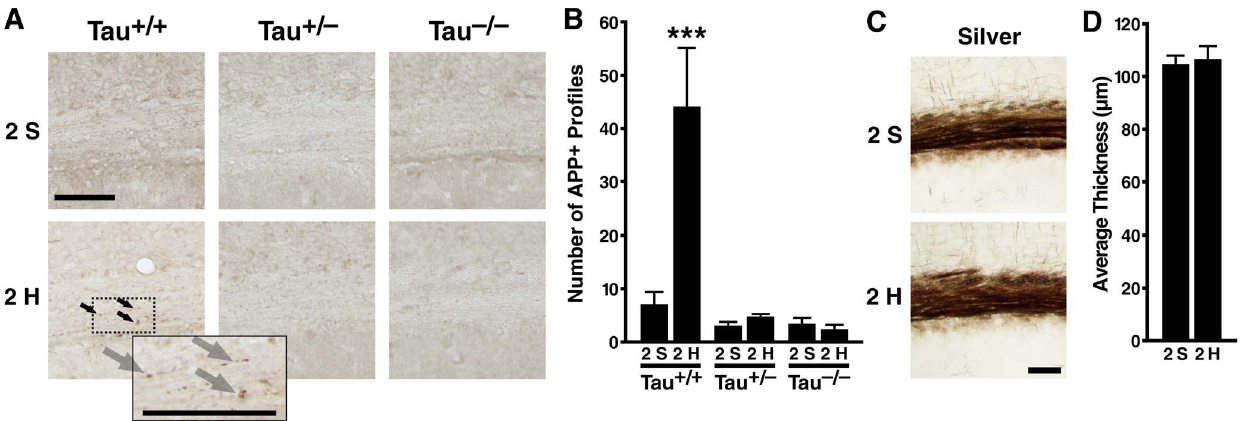
Fig. 8. Tau reduction prevents chronic axonopathy in corpus callosum of 2-hit mice. Tau + / + , Tau + /– and Tau –/– mice (n 5 8–10 per genotype and treatment) received a 2-hit frontal impact injury or sham treatment, underwent behavioral testing 2–6 weeks later, and were analyzed histologically 12 months after the initial injury. (A, B) Coronal brain sections were immunostained for mAPP (22C11). (A) Photomicrographs depicting abnormal mAPP- positive profiles in the corpus callosum of a 2-hit Tau + / + mouse that are not seen in the other mice. (B) Quantitation of mAPP-positive profiles in the corpus callosum. Two-way ANOVA revealed a Tau genotype effect (p 5 0.0011, F (2, 45) 5 7.94), a 2-hit injury effect (p 5 0.027, F (1, 45) 5 5.25) and an interaction between Tau genotype and injury (p 5 0.008, F (2, 45) 5 5.42). ***p , 0.001 vs. sham-treated group of same genotype (Tukey-Kramer test). (C,D) Axons in the corpus callosum of 2-hit and 2-sham Tau + / + mice were labeled by silver staining. (C) Representative photomicrographs. (D) The thickness of the corpus callosum was quantitated as described in Methods. Student’s t test revealed no significant difference between the groups. Sh, Sham, H, Hit. Scale bar: 80 m m. Data are means ¡ SEM.